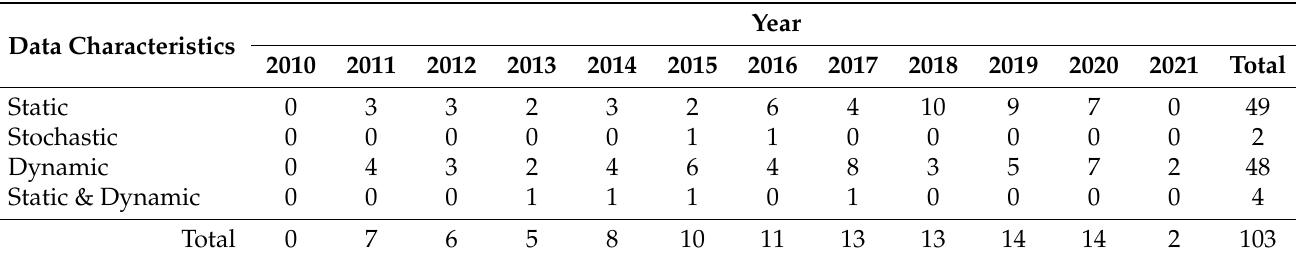
Table 5. Distribution of Papers based on the Data Characteristics over the Years.